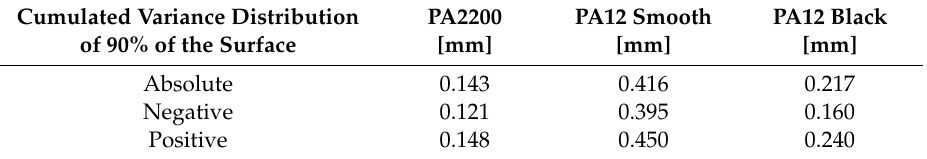
Table 7. Actual / Nominal Analysis Results of Benchmark’s Computed Tomography (CT) Scans.